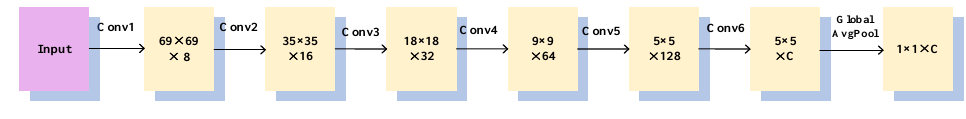
Figure 7. Fast mask re-scoring network .